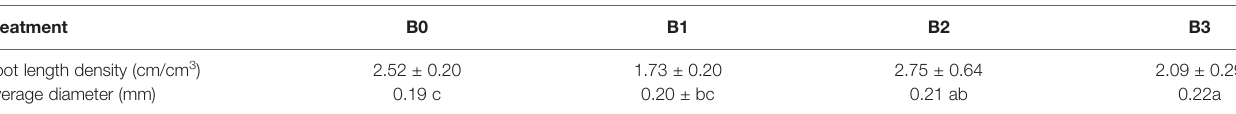
TABLE 3 | Root length density and average diameter at 50 – 70 cm in 2015. Treatment